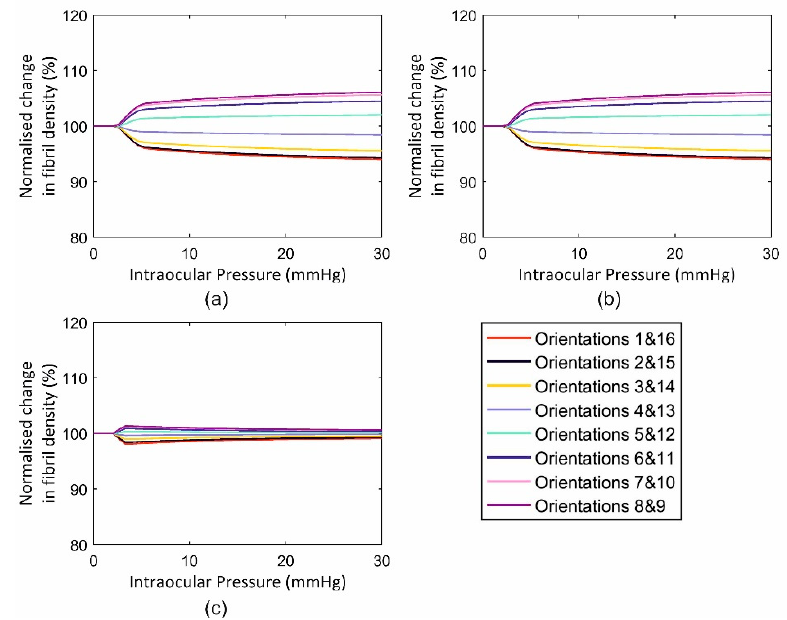
Figure 11. Fibril reorientation in a model of an inflated ocular globe with anterior cornea removed under intraocular pressure up to 30 mmHg at three locations across the cornea including ( a ) element 1, ( b ) element 2 and ( c ) element 3.